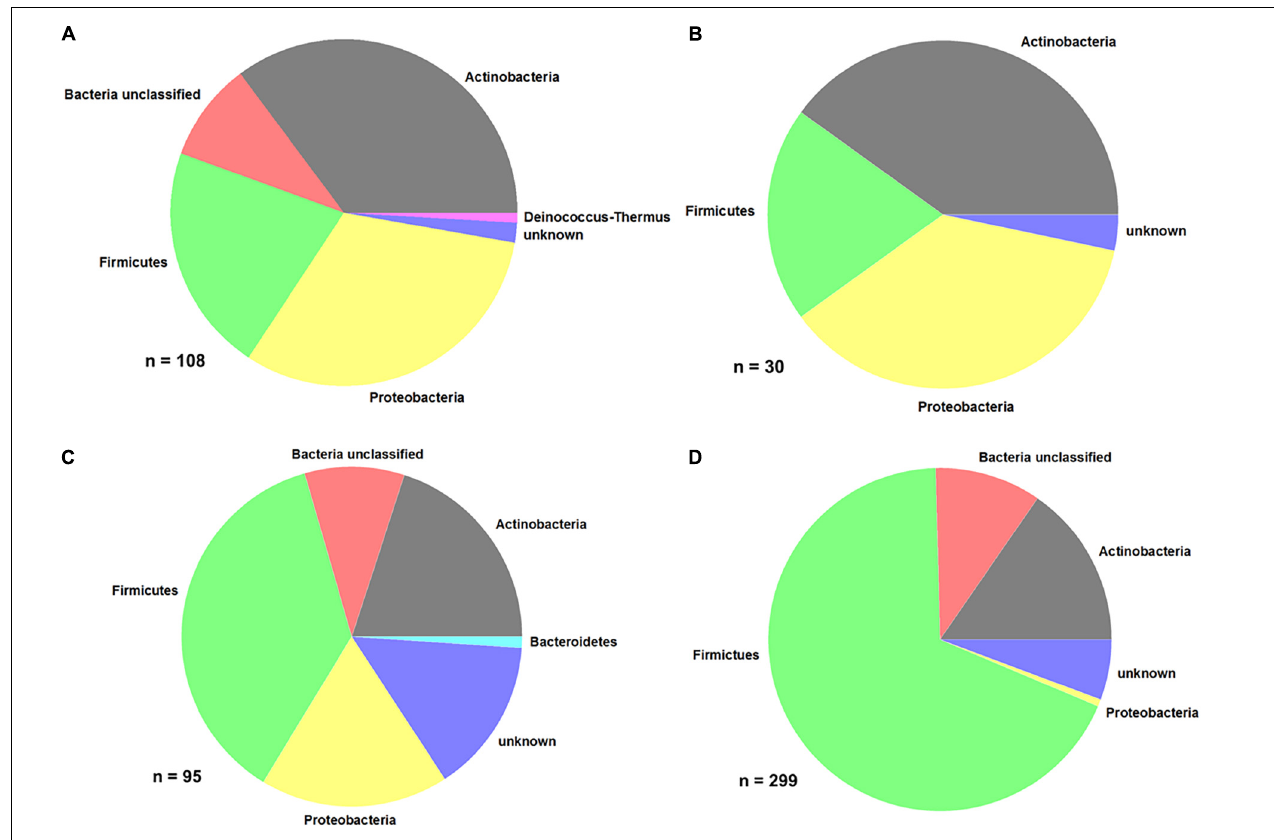
FIGURE 5 | Distribution of bacterial phyla. (A) Produce, (B) EDEN ISS plants, (C) liquid nutrient samples, and (D) surface samples